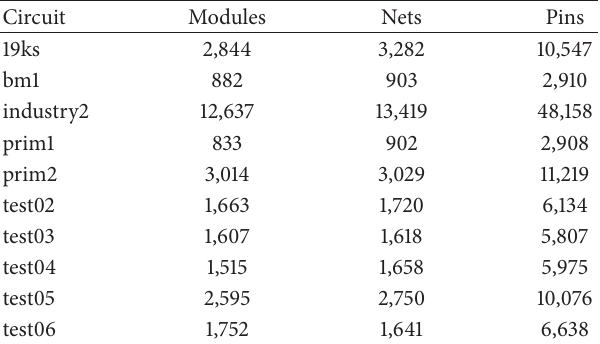
Table 1: Specification of tested